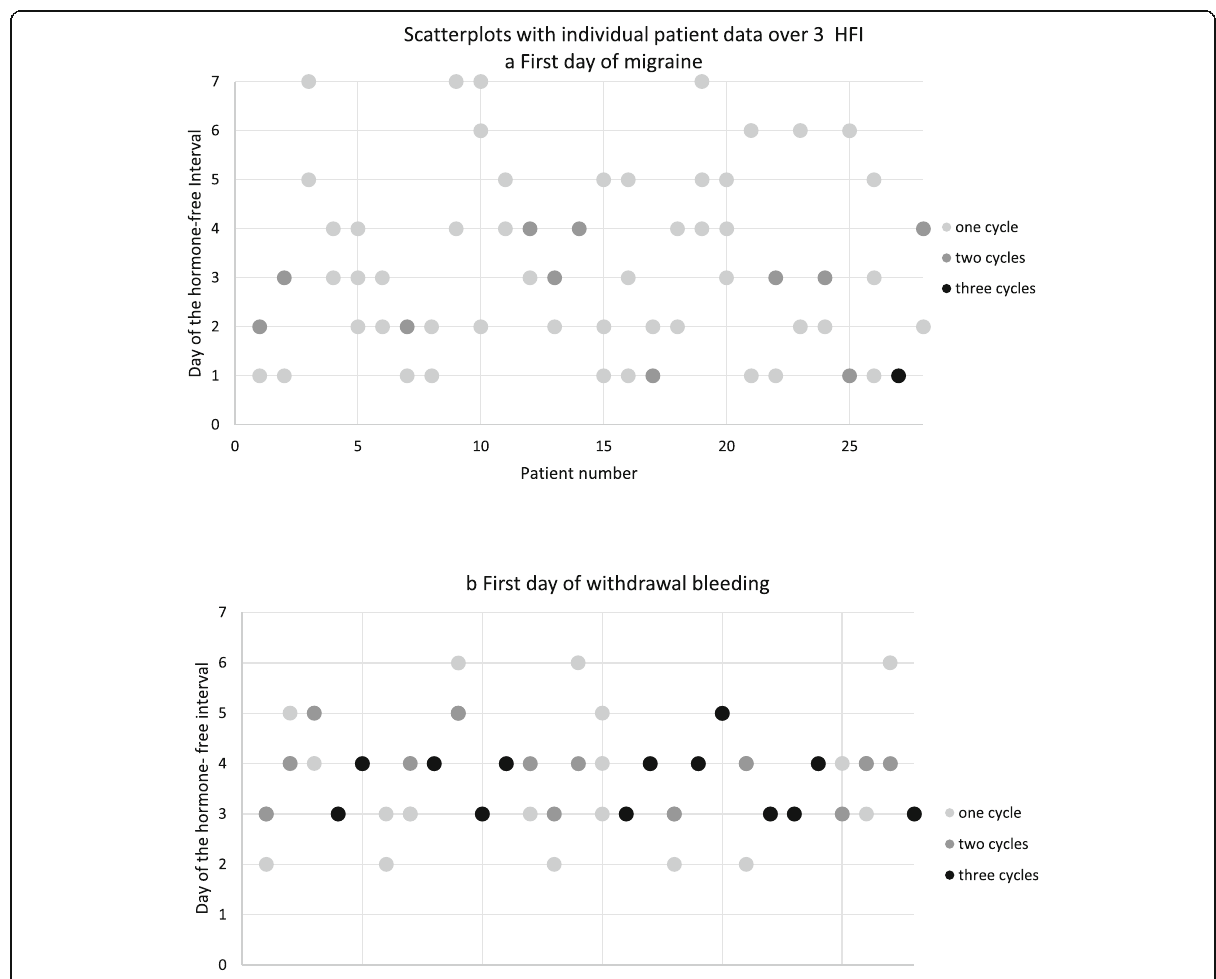
Fig. 5 a / b : Scatterplots with individual patient data over 3 hormone-free intervals: a first migraine day and b: first bleeding